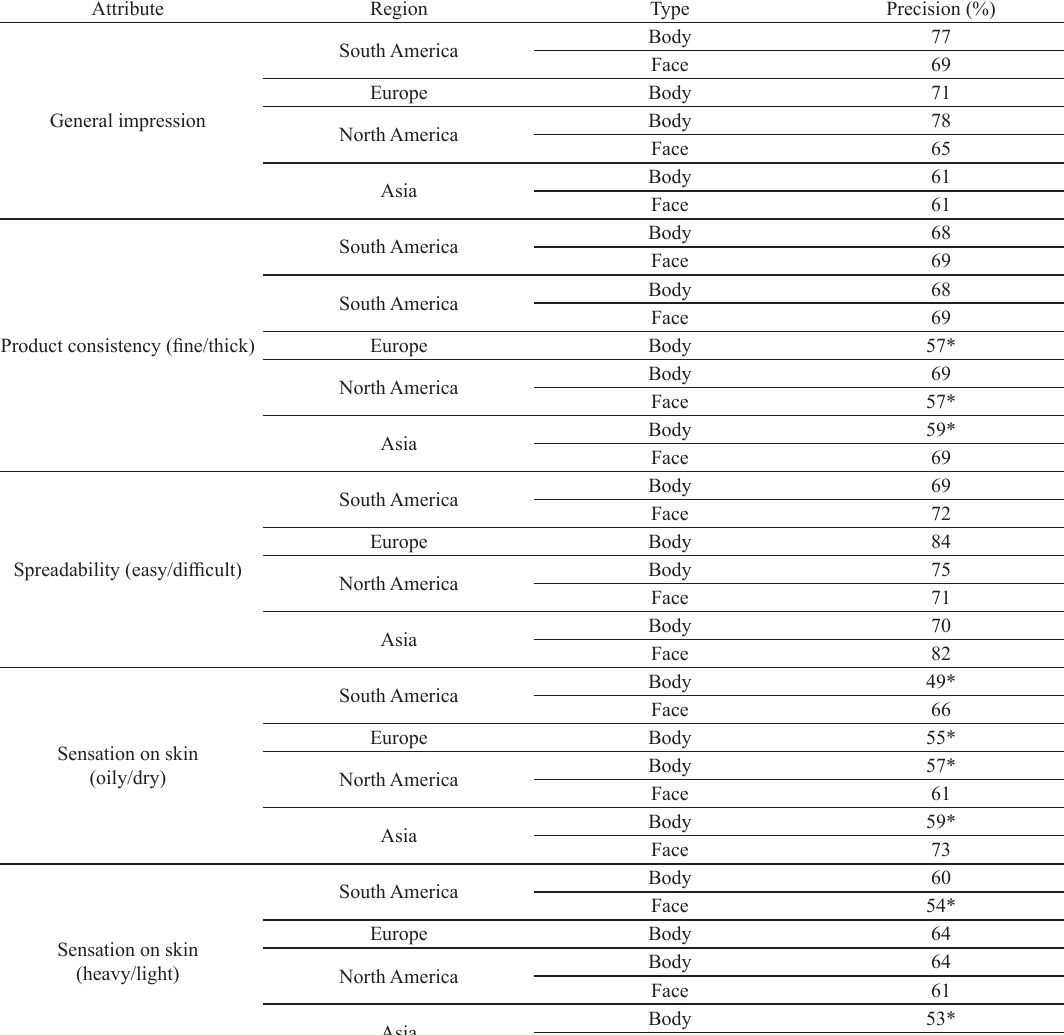
Table 6. Percentage precision for the correlation between consumer perception and rheological data obtained employing the prediction model based on neural networks. Attribute